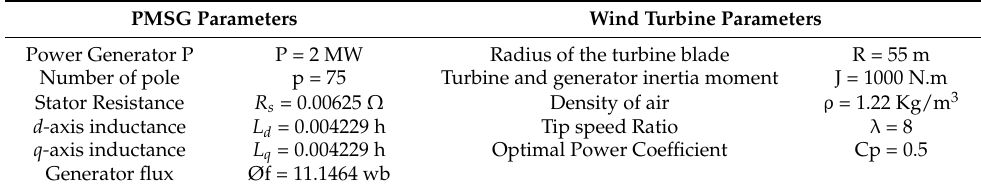
Table A1. Wind turbine system